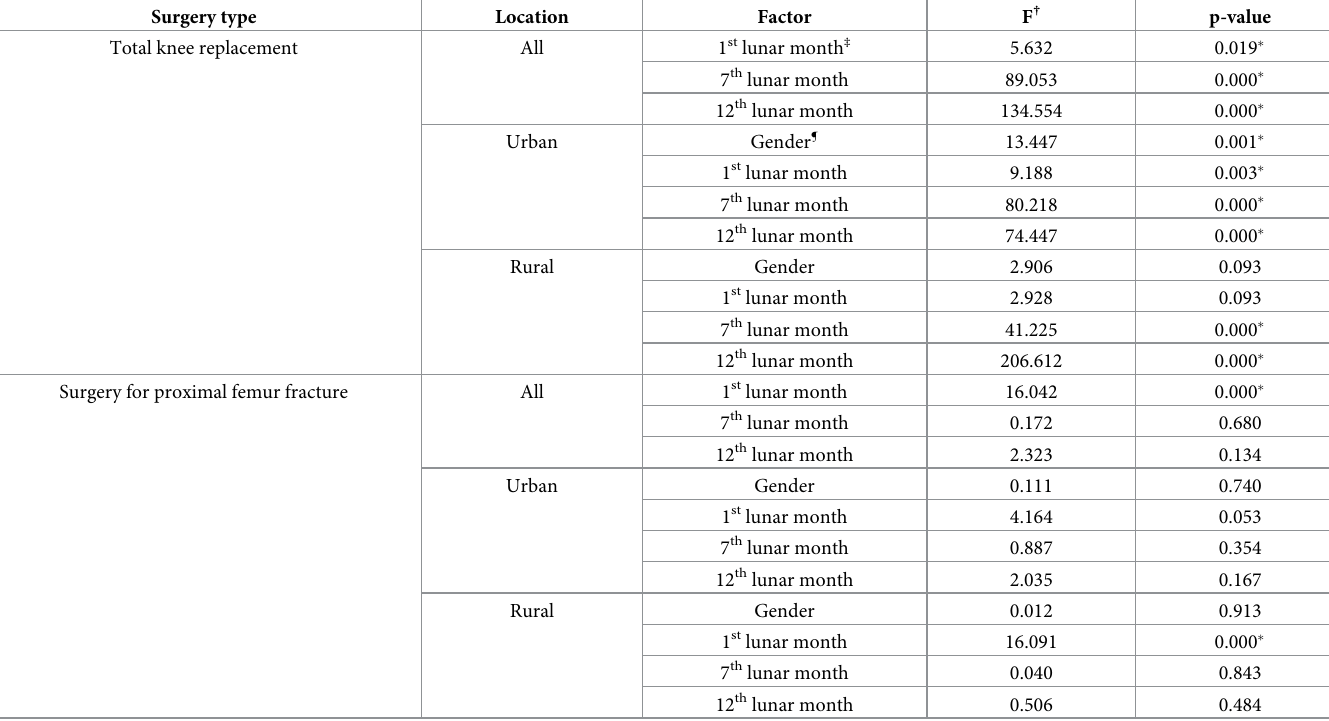
Table 3. Mixed model analysis of the average number of surgeries categorized by the type of surgery and patients’ location of residence. Surgery